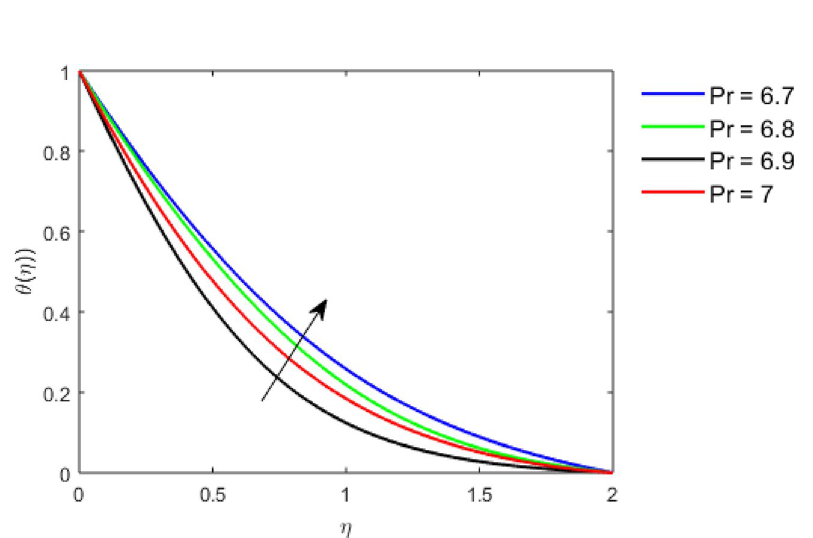
Figure 10. Thermal profile for increasing Pr , with n = 1.1, m = 2, r = 0.6